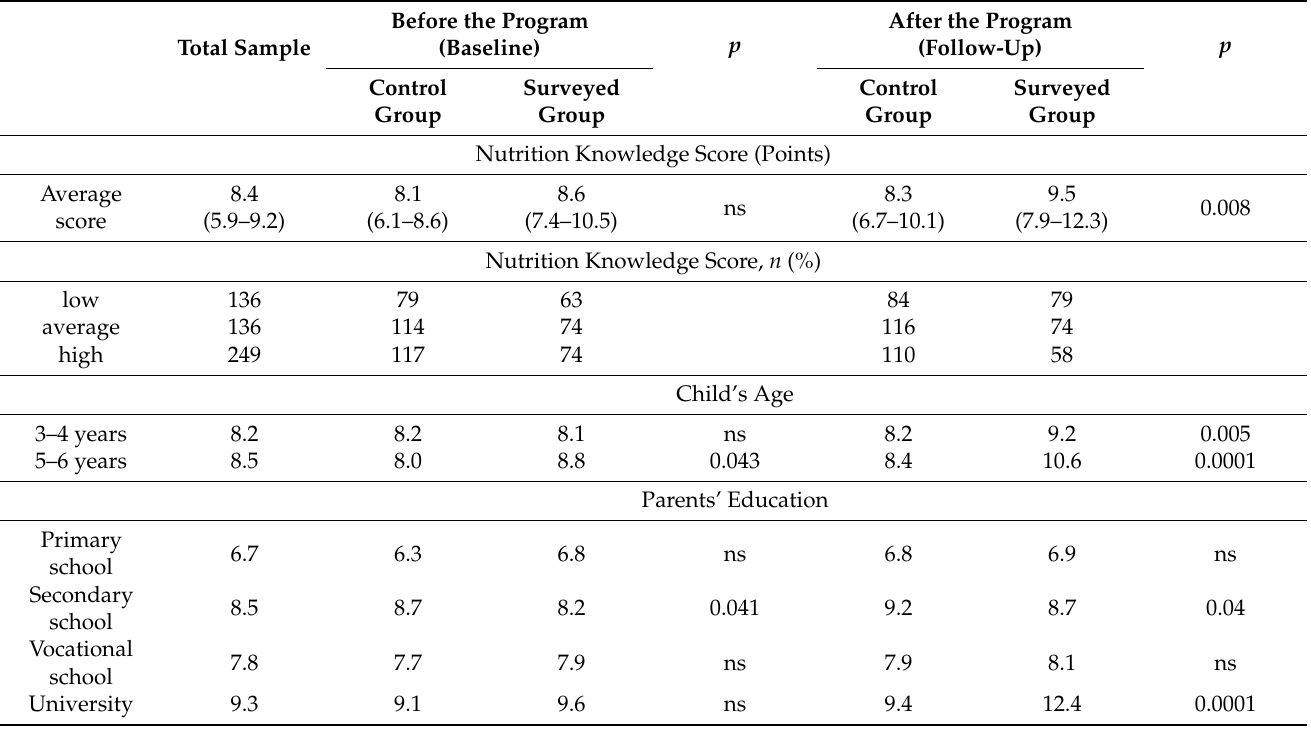
Table 6. Nutrition knowledge scores (in points) and factors contributing to differences in parental nutrition scores in the overall population, in the control group and in the surveyed group before and after the 6-month educational